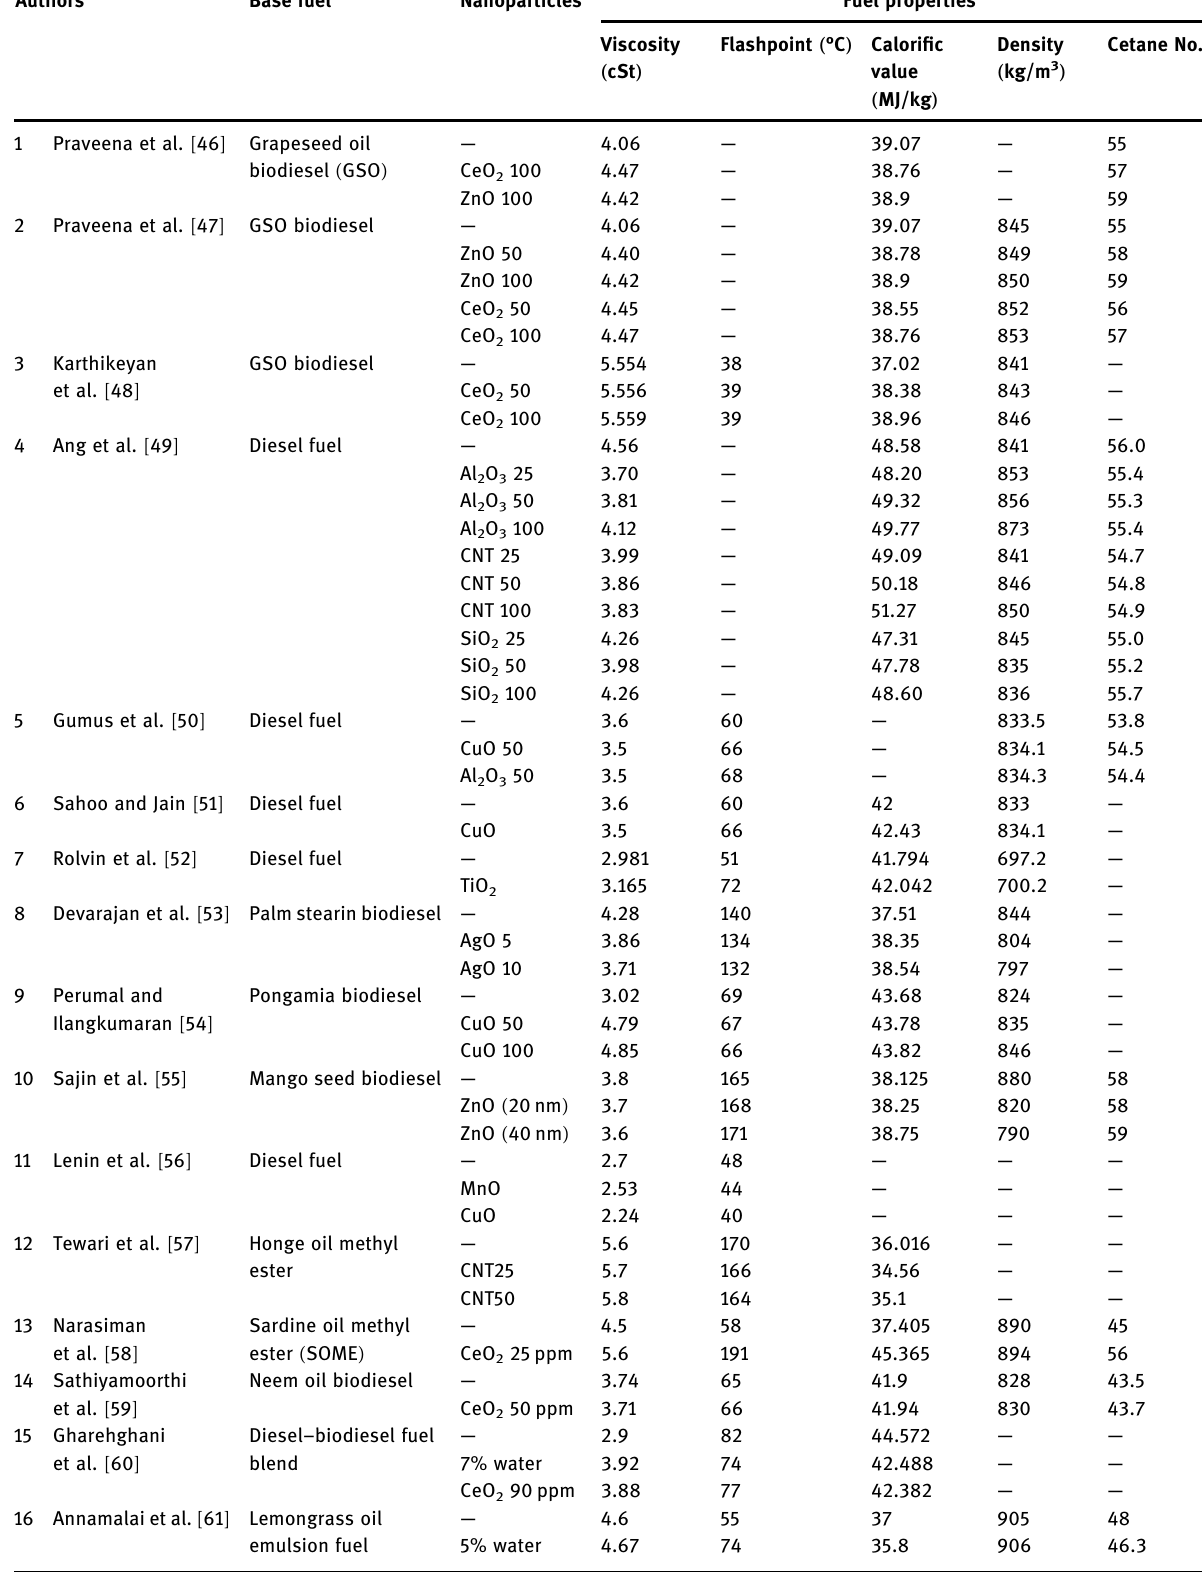
Table 1: Comparison between fuel properties of nanoparticles doped in diesel/biodiesel